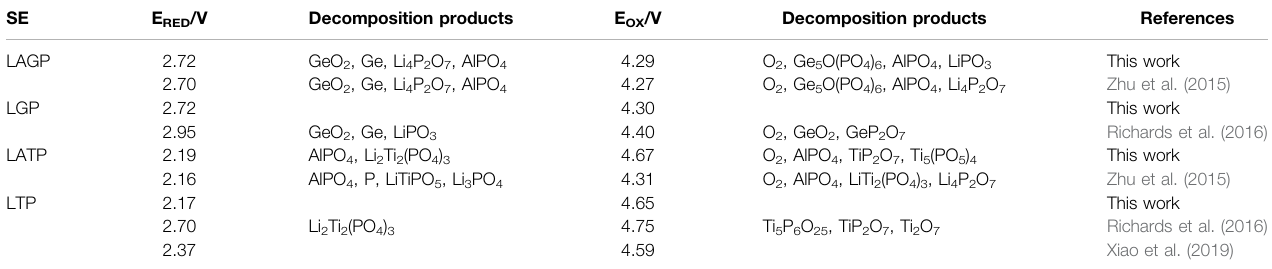
TABLE 2 | Computed electrochemical stability windows for LAGP and LATP using the GPPD and their computed decomposition products. SE E RED /V Decomposition